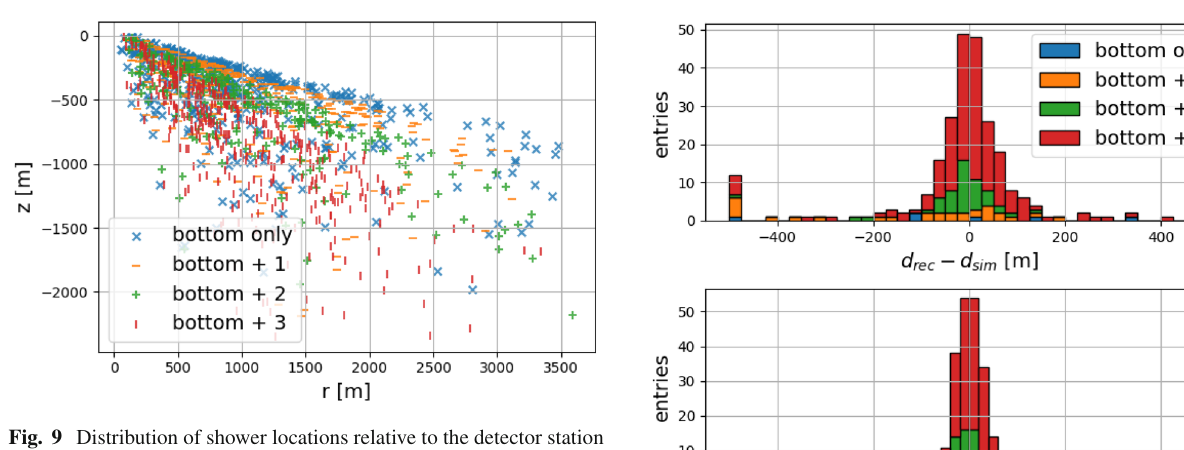
Fig. 9 Distribution of shower locations relative to the detector station for events that have signals with SNR > 2 . 5 only for the channels at ∼ 100 m depth and for 1, 2, or 3 of the other channels on the power string as well. For better readability, only every second event is drawn